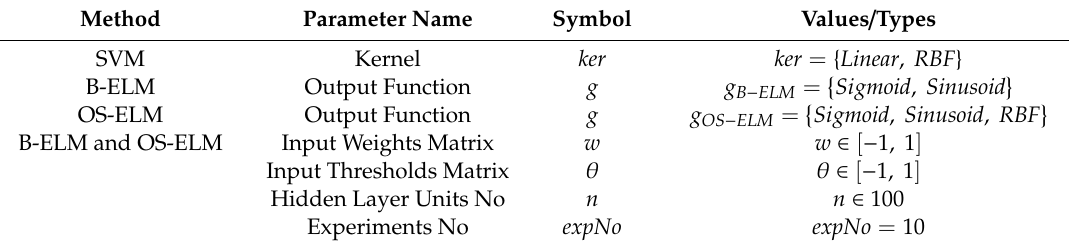
Table 2. Parameter